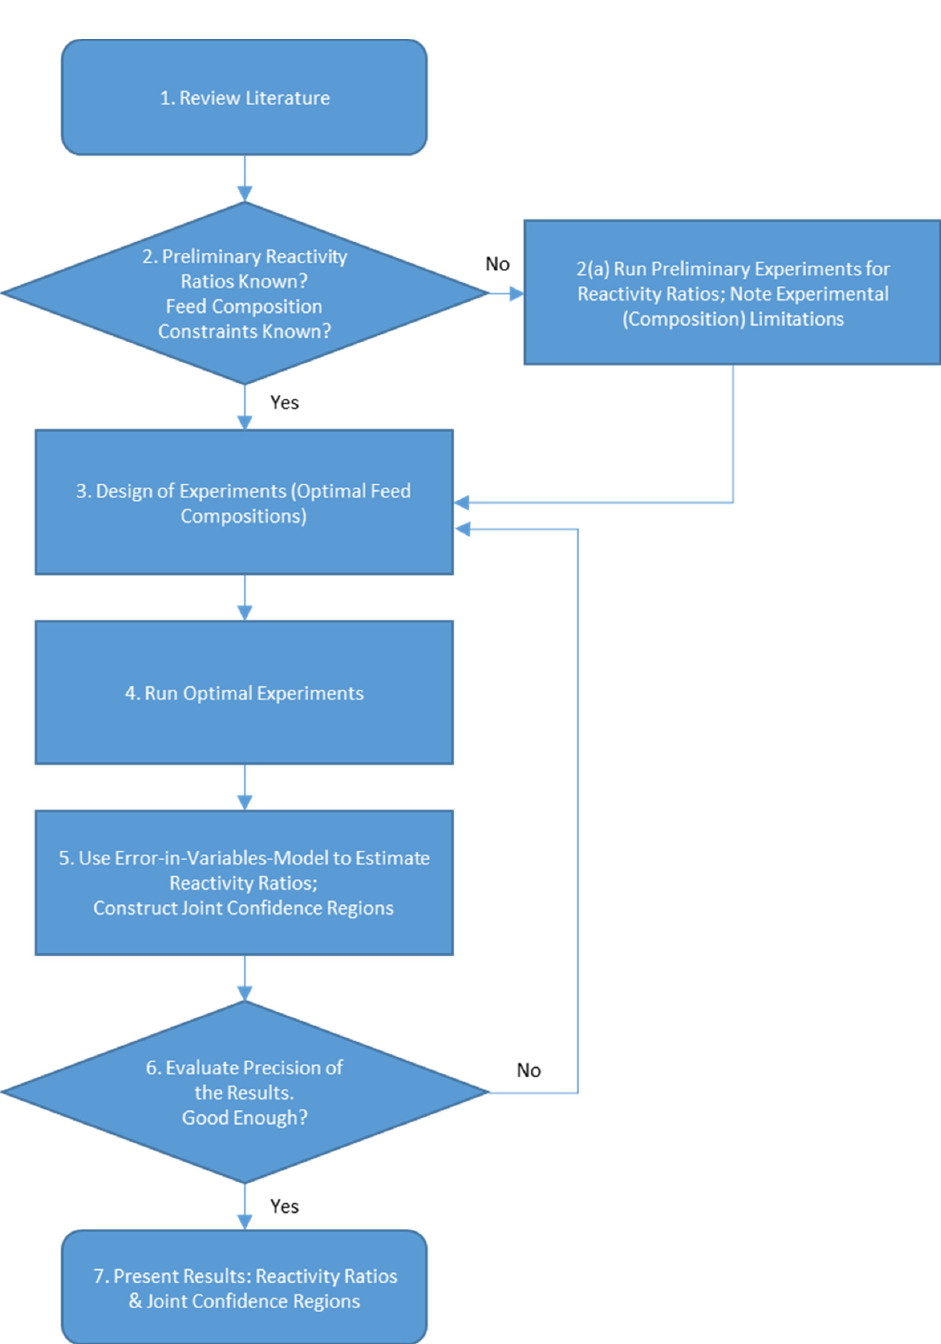
Figure 1. Flowchart of the EVM (error-in-variables-model) framework for ternary reactivity ratio estimation.